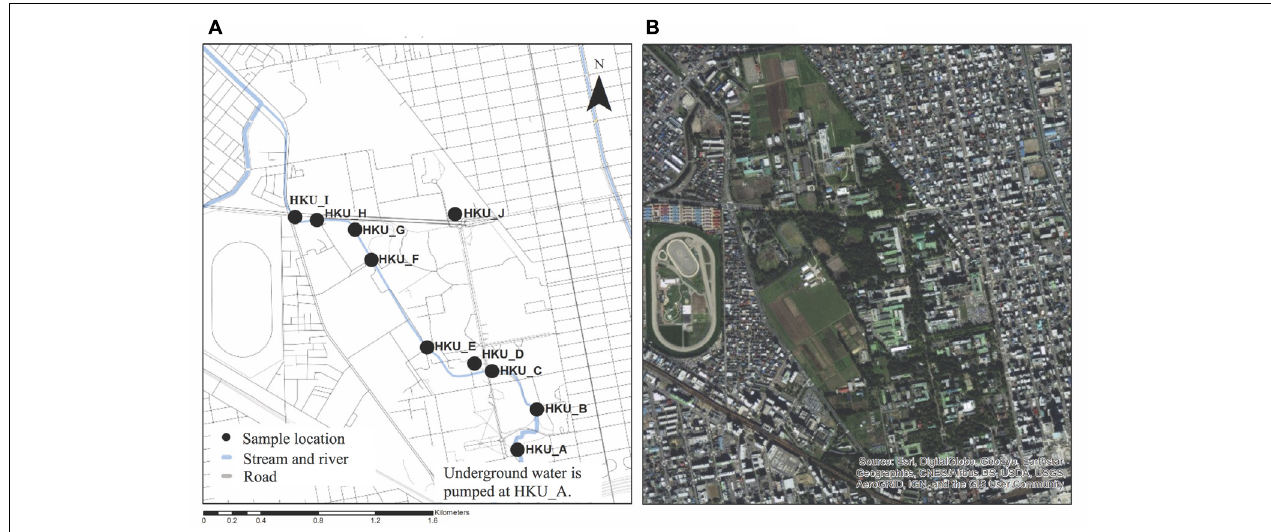
FIGURE 1 | Locations of sample collection. Water samples were collected from Sakushukotoni stream (HKU_A, HKU_B, HKU_C, HKU_E, HKU_F, HKU_G, HKU_H, and HKU_I), Ohno Pond (HKU_D), and Hyotan Pond (HKU_J). (A) A map from OpenStreetmap. (B) A satellite image from Google